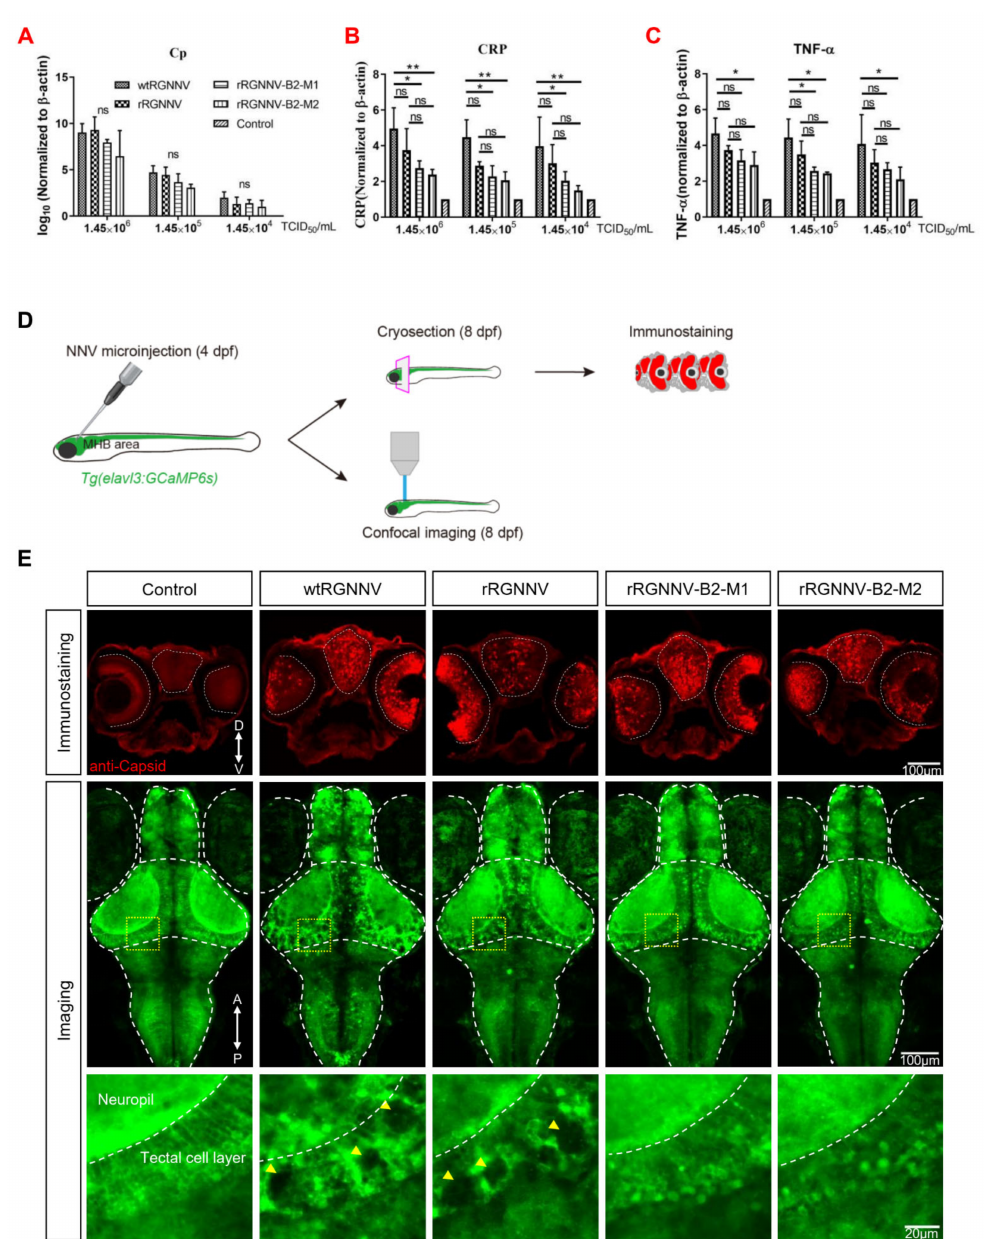
Figure 4. Virulence of wtRGNNV, rRGNNV, rRGNNV-B2-M1 and rRGNNV-B2-M2 viruses in ze- brafish. ( A ) Virus load of zebrafish infected with wtRGNNV, rRGNNV, rRGNNV-B2-M1, or rRGNNV- B2-M2 was measured by RT-qPCR of RGNNV. Cp, capsid protein; ns, not significant. ( B , C ) The mRNA expression of C-reactive protein (CRP) and TNF- α in zebrafish infected with wtRGNNV, rRGNNV, rRGNNV-B2-M1, or rRGNNV-B2-M2 by RT-qPCR. * p < 0.05; ** p < 0.01; ns, not significant. ( D ) Schematics of the experimental procedure for viral infection and viral detection. ( E ) Immunofluo- rescence images of RGNNV capsid protein (Cp) ( top ) and projected transgenic fluorescence-image stacks ( middle ) from larval zebrafish without viral injection or with wtRGNNV, rRGNNV, rRGNNV- B2-M1 or rRGNNV-B2-M2 virus injection. Scale bars, 100 µ m. D, dorsal; V, ventral. Enlarged view of the boxed regions in optic tectum were shown at the ( bottom ). Yellow arrowheads indicate massive tissue vacuolization. Scale bar, 20 µ m. A, anterior; P, posterior. Data shown in ( A – C ) are mean ± SD of three independent experiments. * p < 0.05; ** p < 0.01; ns, not significant; by two-way ANOVA. All experiments were performed in